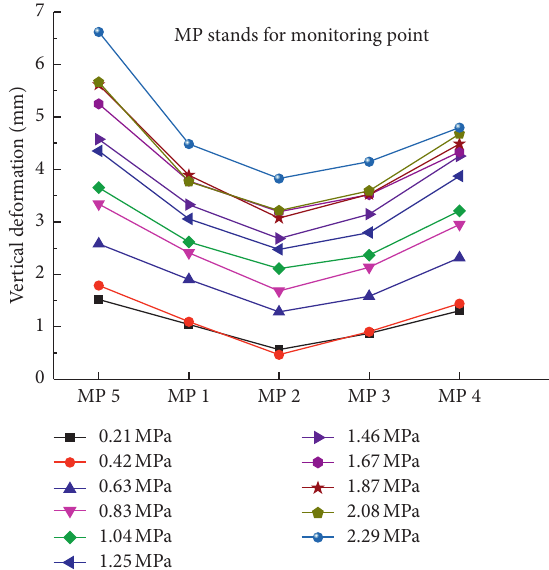
Figure 6: The settlement curve of monitoring points.